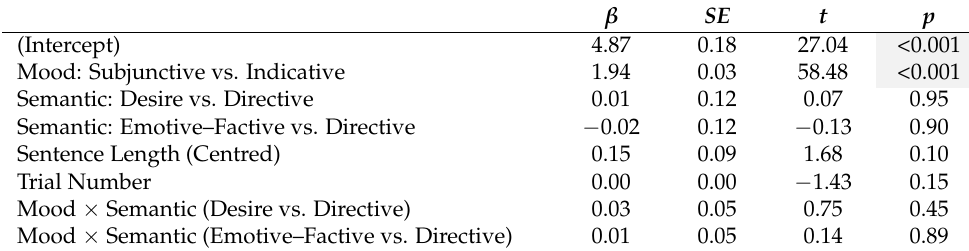
Table A3. Estimates from the mixed-effect model for L1 judgment data.